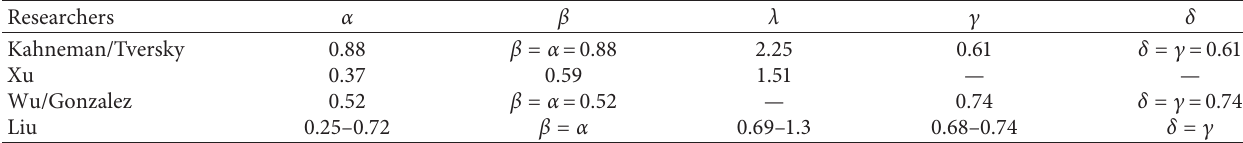
Table 5: Results of some other typical studies.